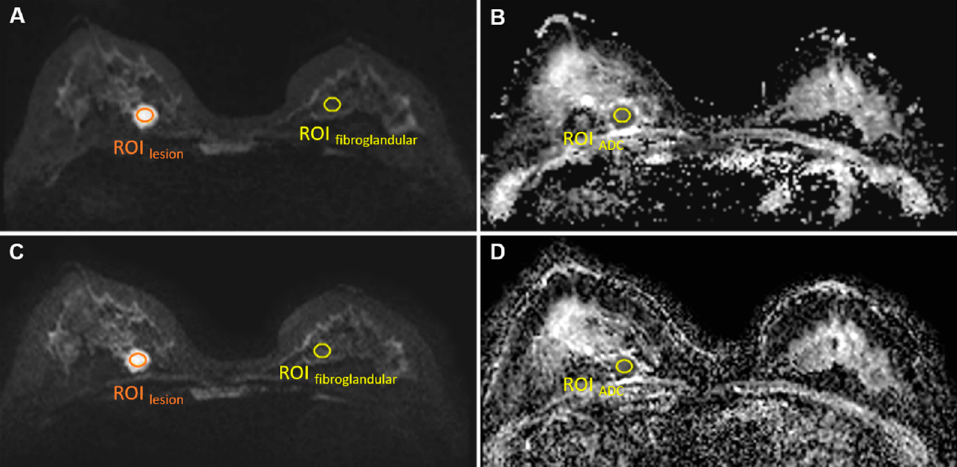
Figure 1. ROI lesion , ROI fibroglandular on b = 1000 s/mm 2 images conventional rs-EPI ( A ) and SMS rs-EPI ( C ); ROI ADC on ADC map of conventional rs-EPI ( B ) and SMS rs-EPI ( D